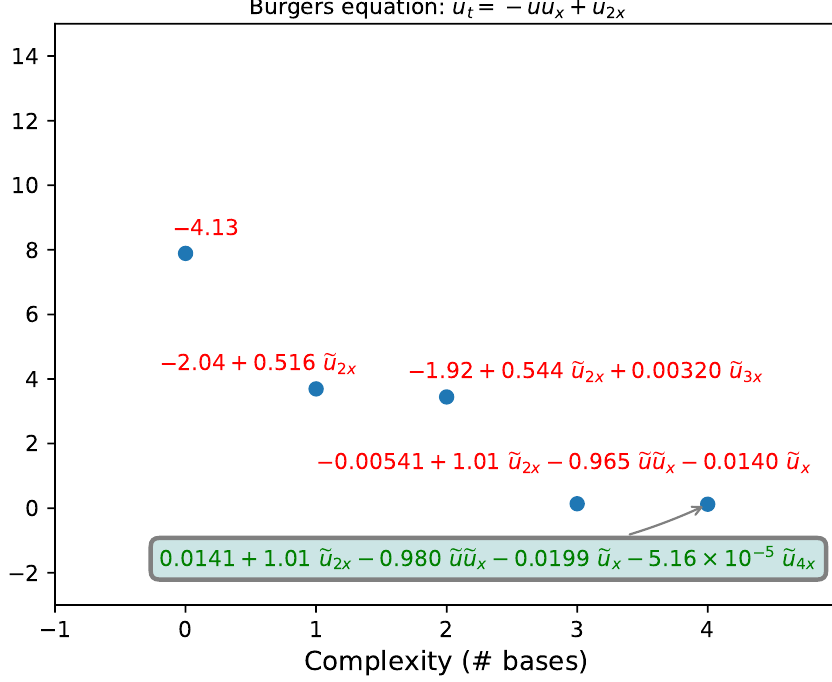
Figure 7. Predicted models with varied test error and complexity for Burgers